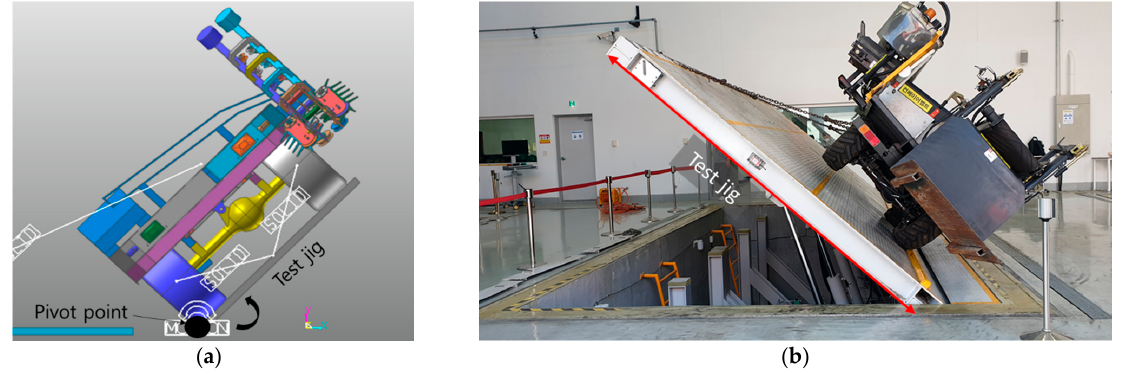
Figure 5. The conditions of the rollover test for tilt angle: ( a ) simulation of the lateral overturning and ( b ) validation test of the lateral overturning of the radish harvester.